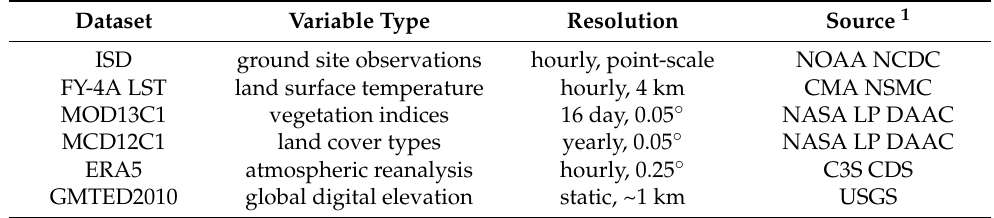
Table 1. Data sources from which the input variables for SAT estimation models were extracted. Dataset Variable Type Resolution Source 1 ISD ground site observations hourly, point-scale NOAA NCDC FY-4A LST land surface temperature hourly, 4 km CMA NSMC MOD13C1 vegetation indices 16 day, 0.05 ◦ NASA LP DAAC MCD12C1 land cover types yearly, 0.05 ◦ NASA LP DAAC ERA5 atmospheric reanalysis hourly, 0.25 ◦ C3S CDS GMTED2010 global digital elevation static, ~1 km